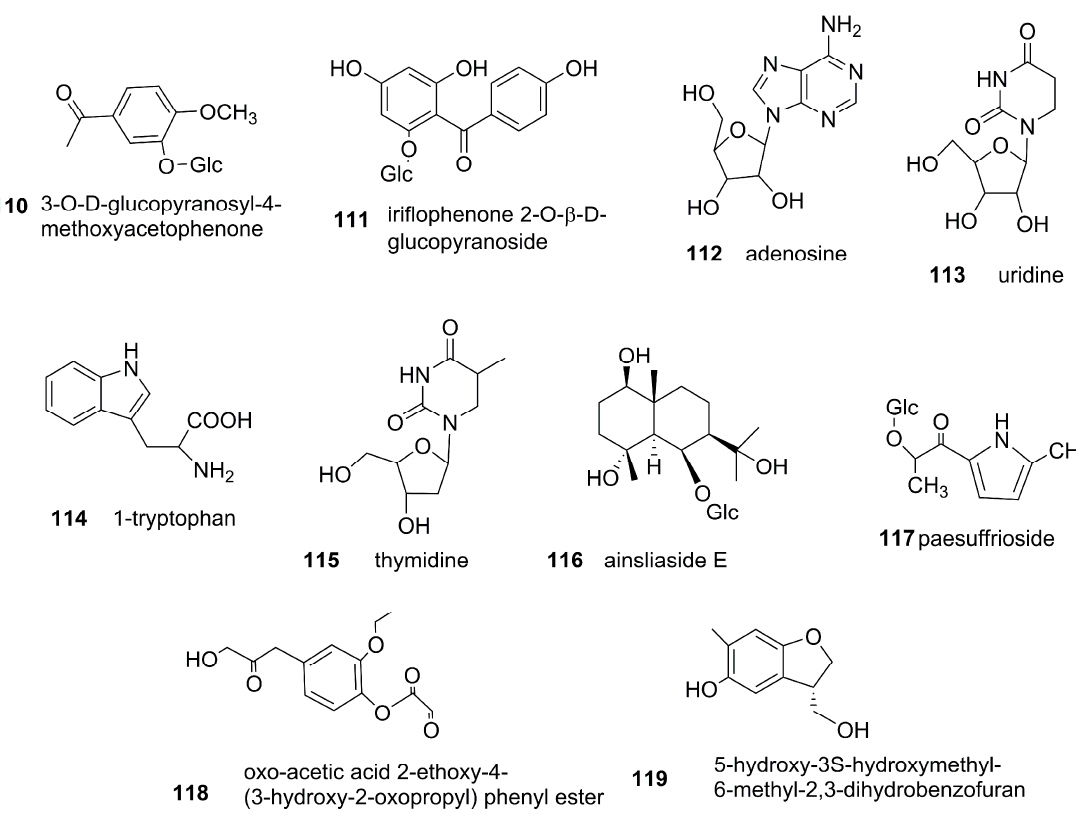
Figure 2. Chemical structures of 119 compounds isolated from CM.